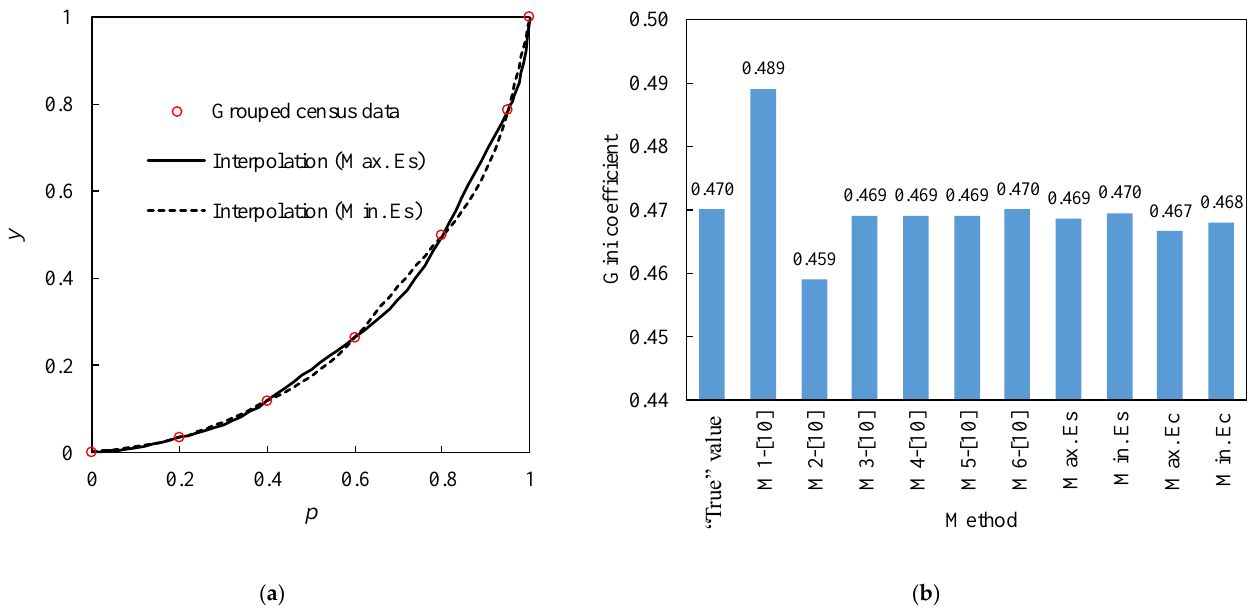
Figure 5. ( a ) Grouped quintiles plus the 95th percentile of US income census data in 2010 [10] and interpolated Lorenz curves based on maximization (Max. Es) or minimization (Min. Es) of approximated strain energy; ( b ) Comparison of Gini coefficients estimated with different methods, where M1-[10] to M6-[10] are six methods used in [10].